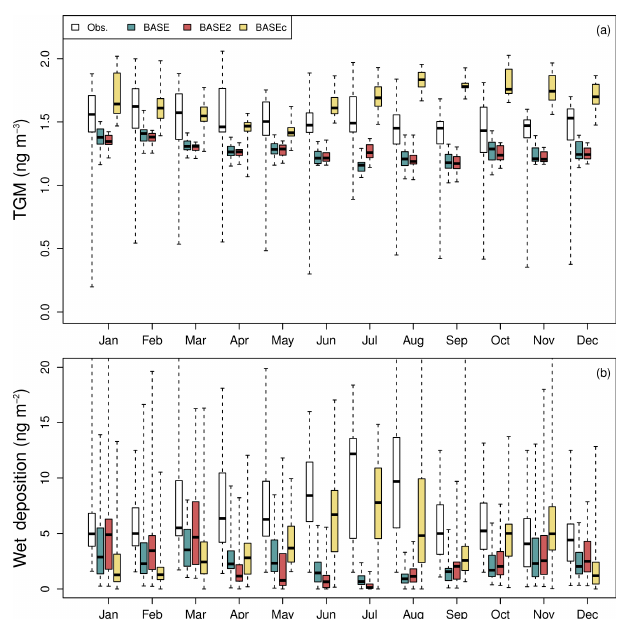
Figure 6. Monthly distribution of observed and modelled values for BASE, BASE2 and BASE C experiments at measurement stations.